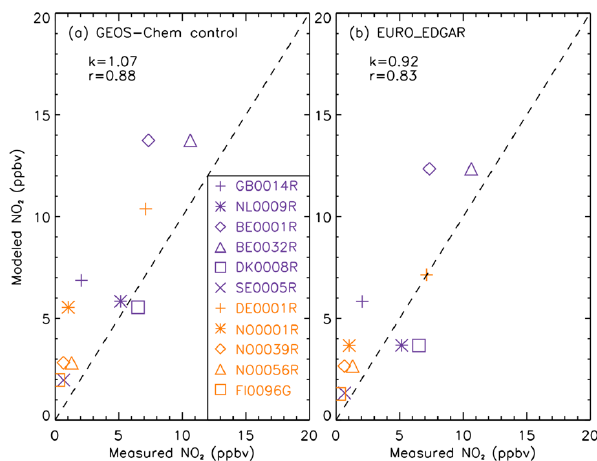
Figure 3. Scatter plots of model simulations from (a) GEOS-Chem control simulations and (b) EURO_EDGAR during 1 Decem- ber 2009–31 January 2010 and measured monthly mean NO 2 mix- ing ratios at 11 observational sites over Europe; also shown are the corresponding model-to-observation slopes ( k ) and correlation co- efficients ( r ) for each panel. The dashed line is the 1 : 1 ratio. Expla- nations of site abbreviations are listed in Table 1. EURO_EDGAR represents simulations with anthropogenic NO x emissions over Eu- rope following EDGAR v4.2, with other model configurations iden- tical to the control